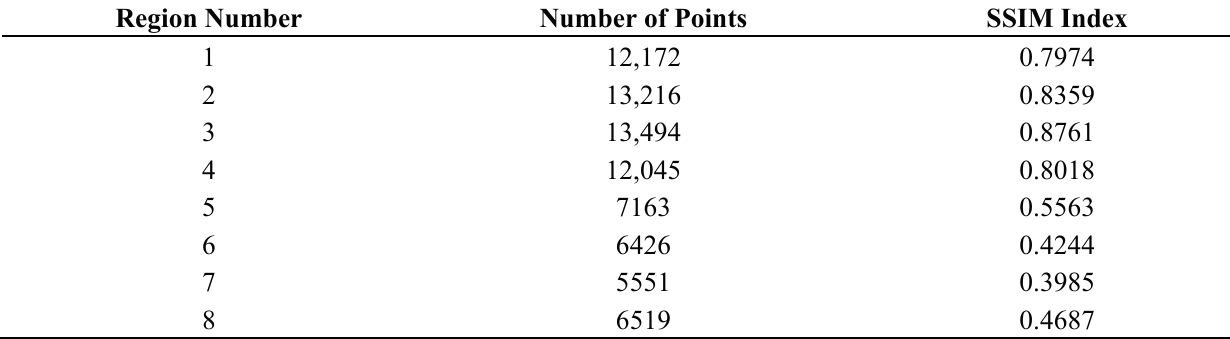
Figure 11. Eight regions on a point cloud density map in a 0.5-meter radius sphere. Table 8. Point density and similarity indices between ANFIS and Logistic Regression (LR) fissure maps in eight